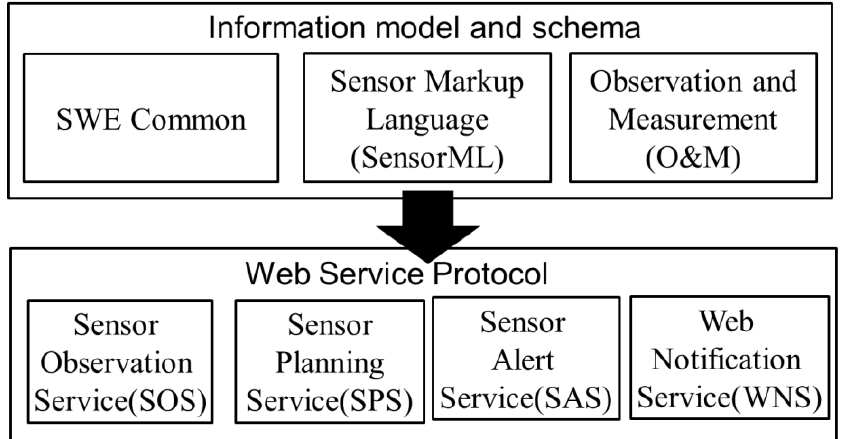
Figure 3. Framework of Sensor Web Enablement